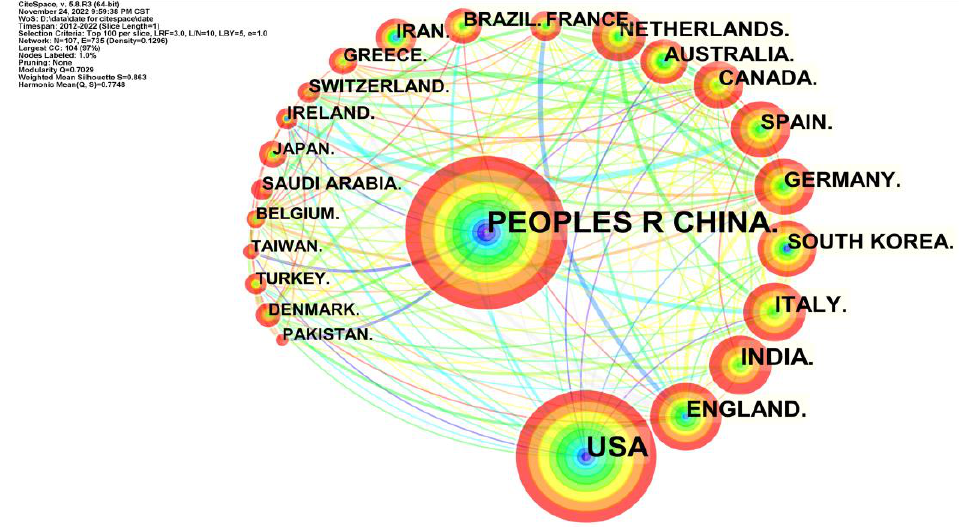
Figure 11. The country co-authorship network of AI-related publications.